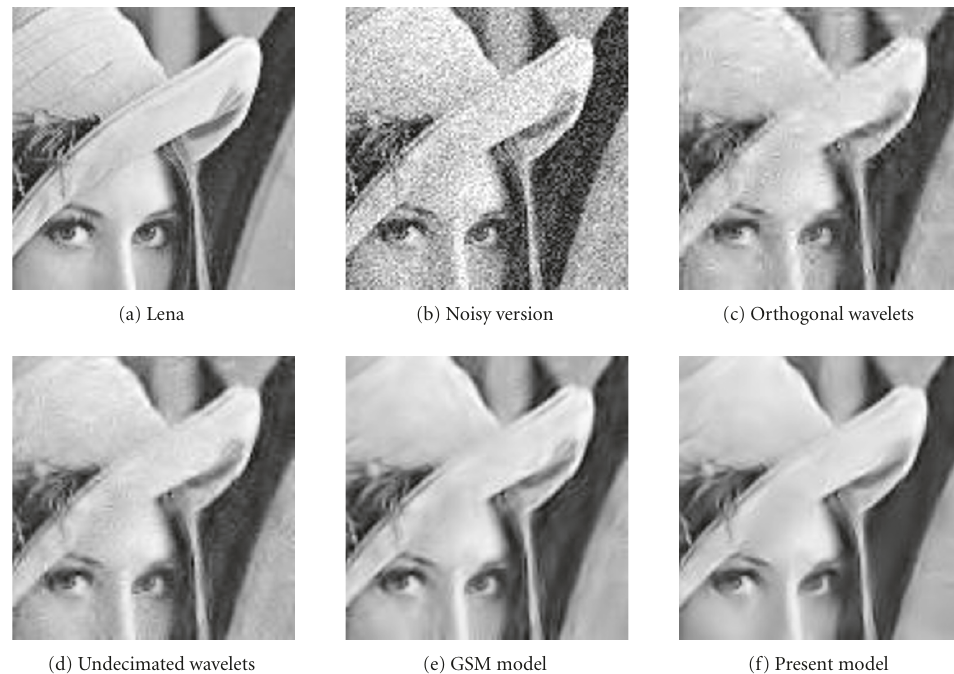
Figure 13: Denoising results with Lena image at medium noise level. (a) 112 × 112 detail of the image “Lena.” (b) Same image corrupted by Gaussian noise for a PSNR of 20 . 22 dB. (c) After denoising using orthogonal wavelets a high level of artifacts appears. (d) The quantity and strength of artifacts is reduced thanks to the use of undecimated wavelets. (e) The GSM model allows an additional reduction of the number of artifacts. (f) The proposed model also allows to reduce the appearance of artifacts, preserving particularly smooth gradients of luminance. Nevertheless the model shows di ffi culties in capturing some intricate features in particular close to junctions (see, e.g., the right eye) and to adjacent parallel lines (e.g., upper end of the hat border).